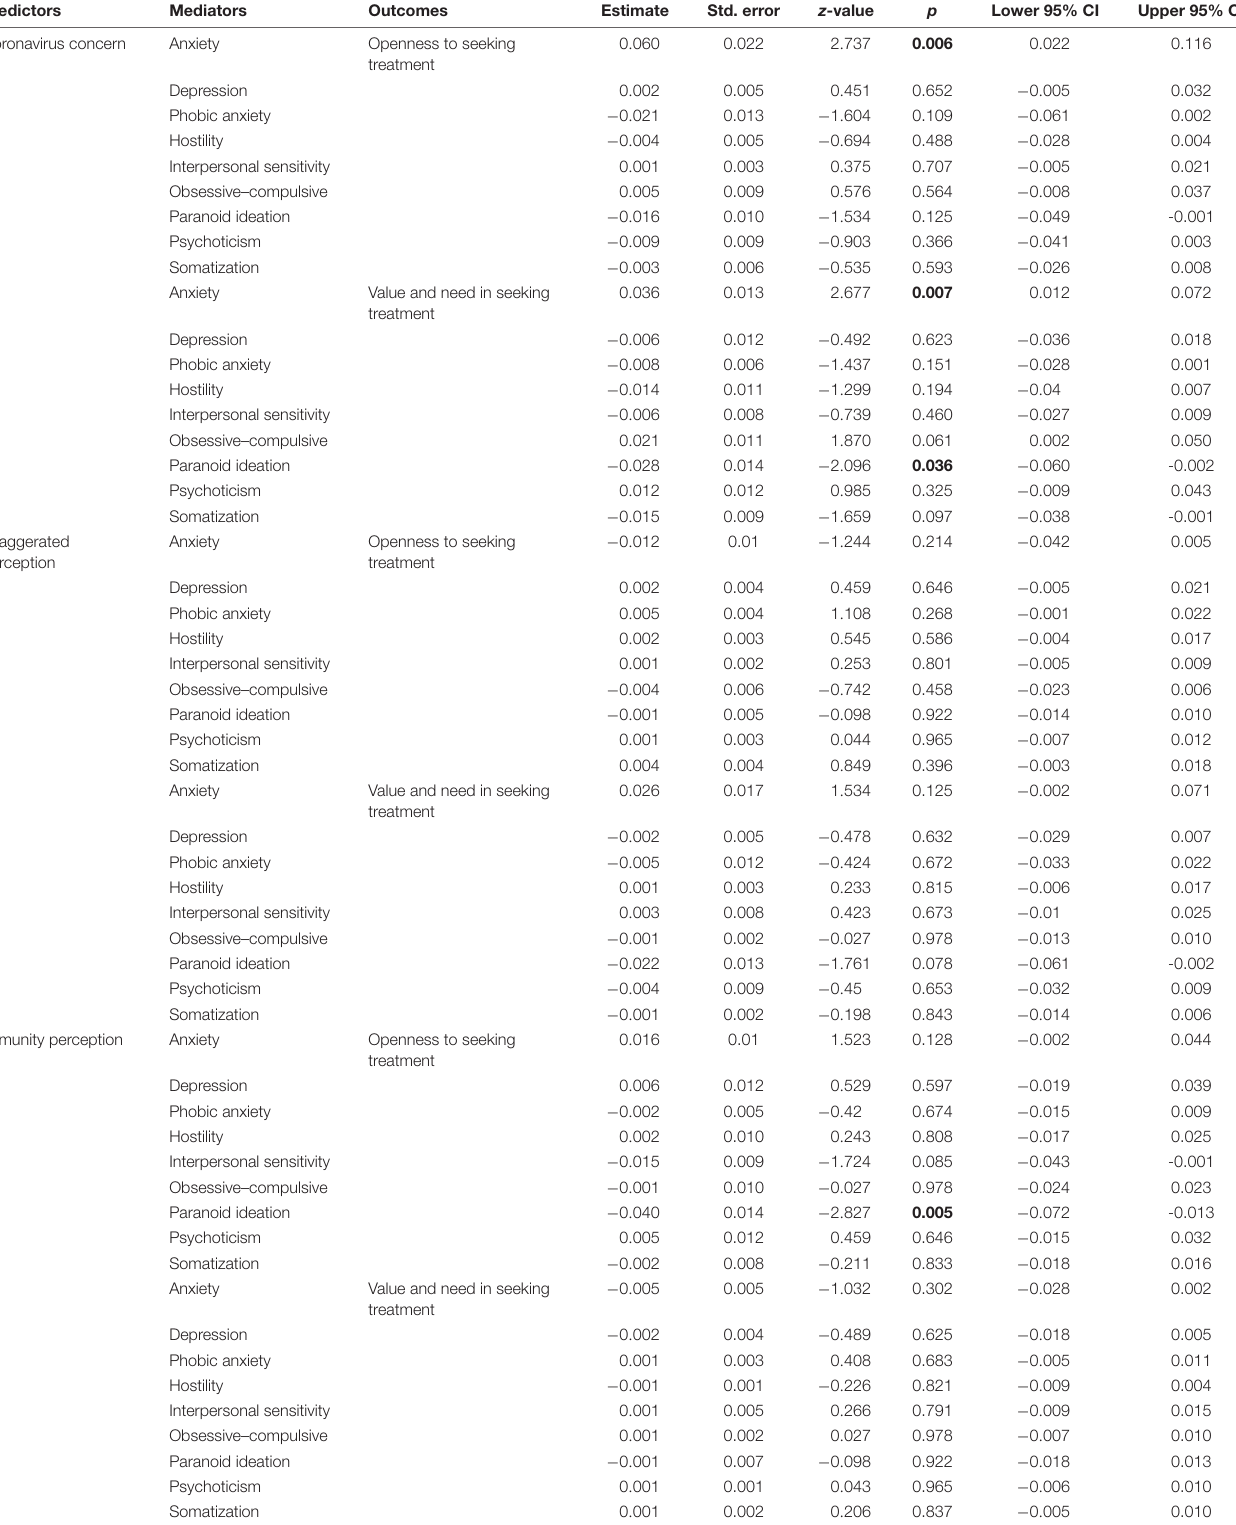
TABLE 7 | Indirect effects of CAS-10 subscales on ATSPPH-SF subscales.